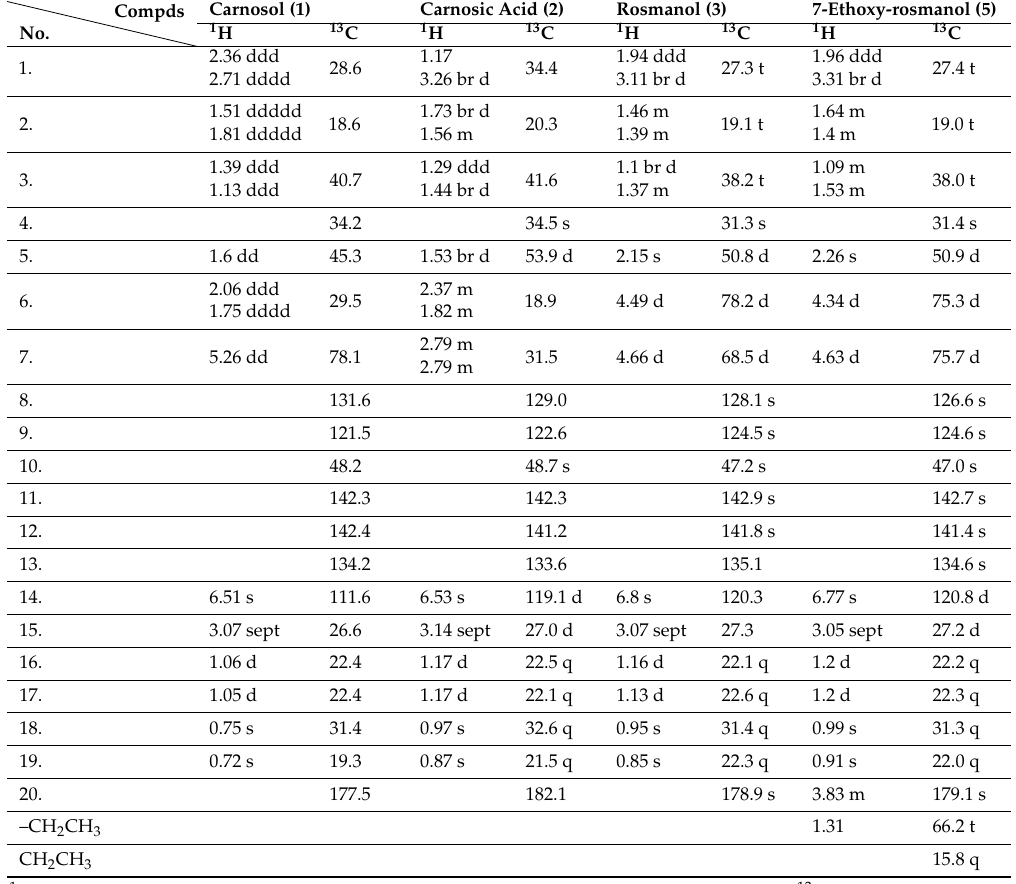
Table 1. 1 H- and 13 C NMR data of 1–3 and 5 in CDCl 3